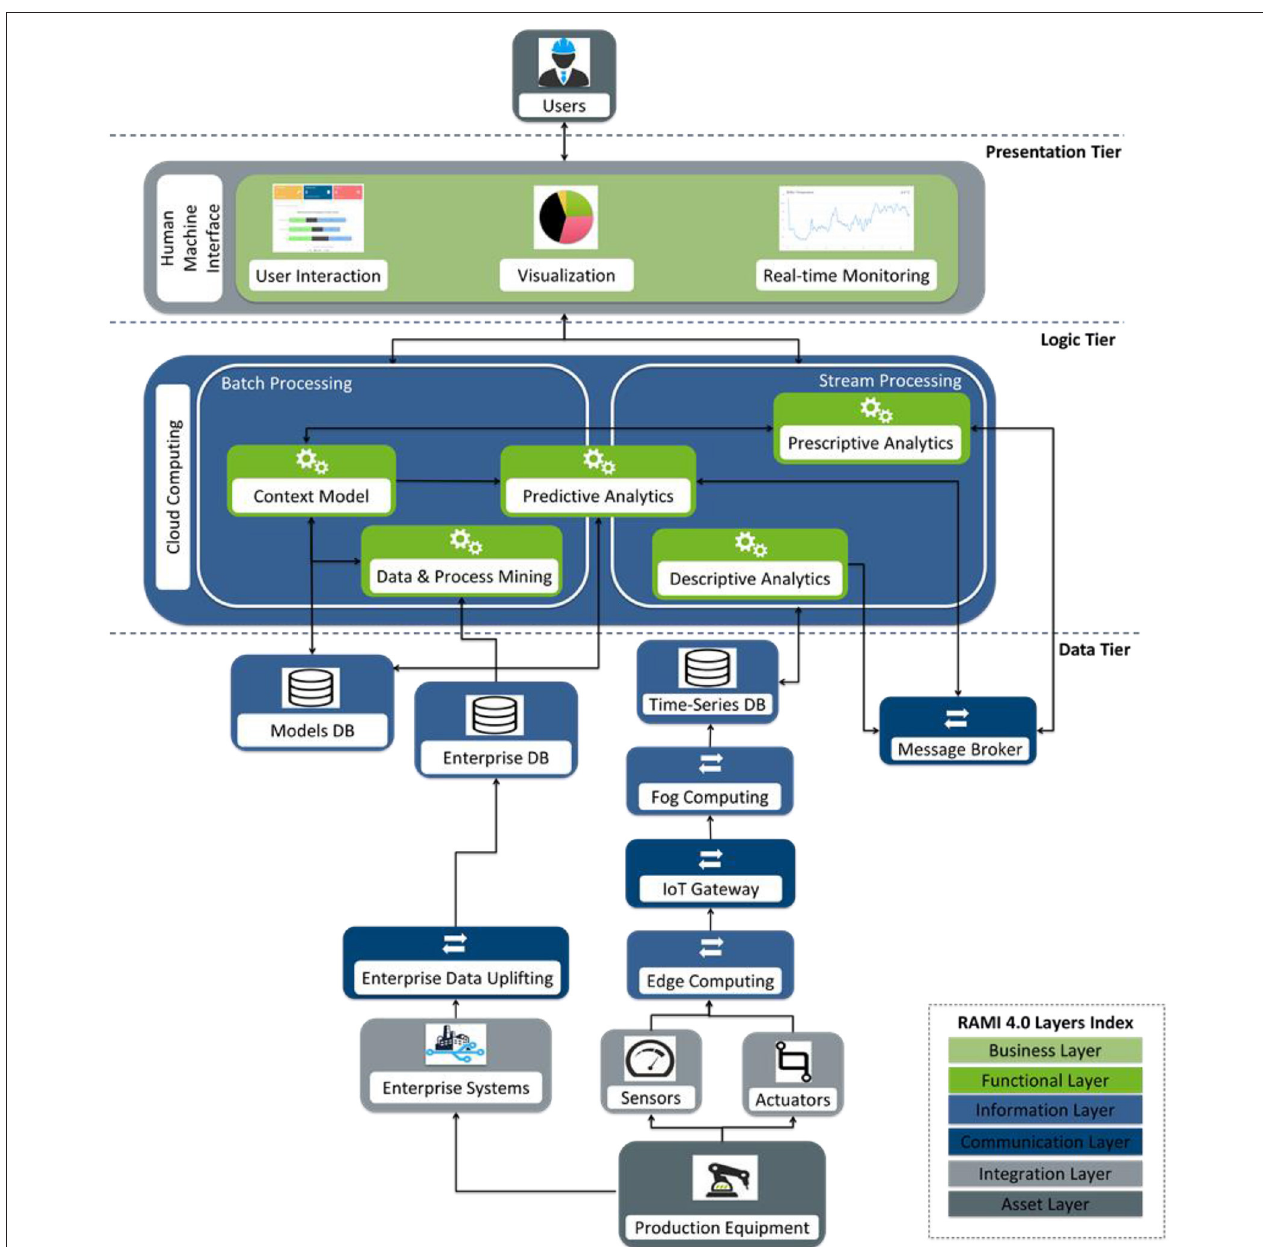
FIGURE 4 | The 3-tier technical view of the architecture for big data-driven processes in Industry 4.0.